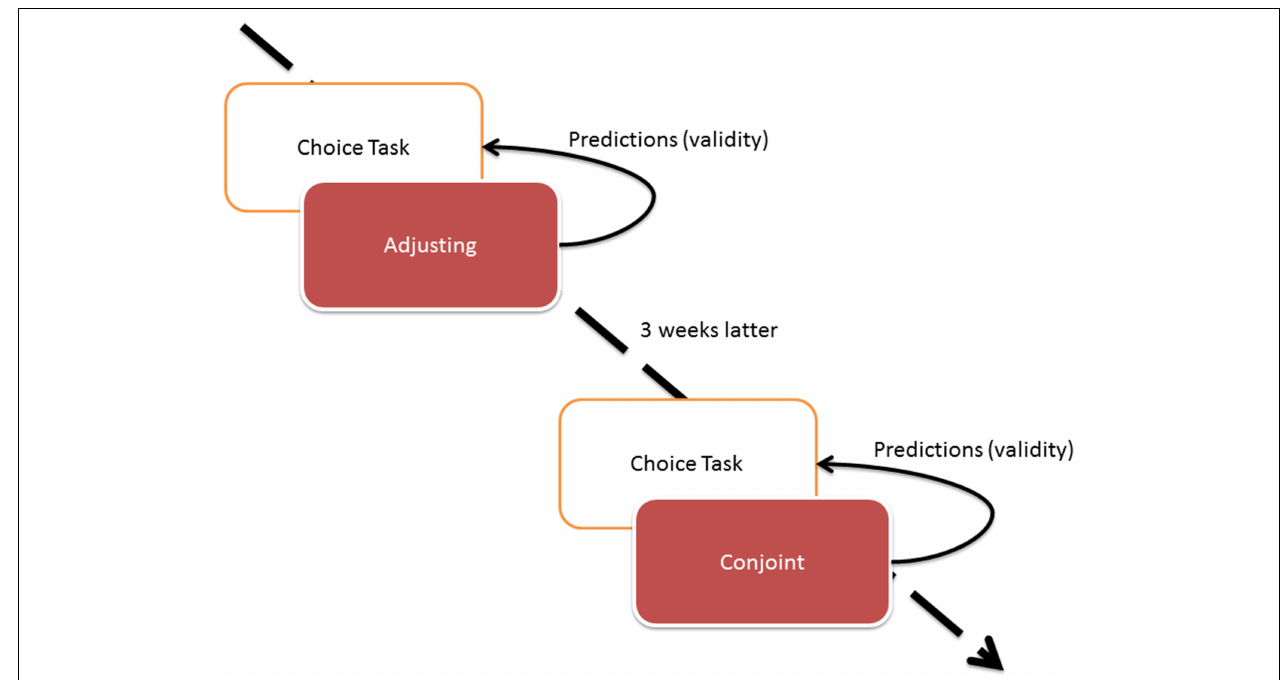
FIGURE 2 | The Study 1 design.